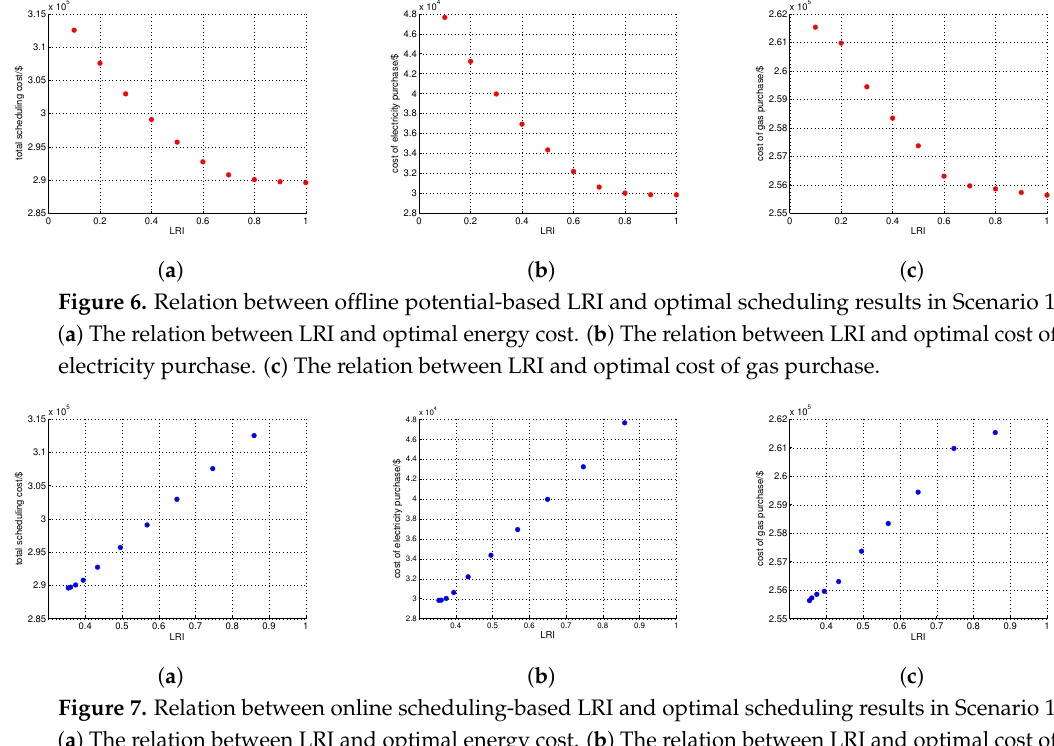
Figure 7. Relation between online scheduling-based LRI and optimal scheduling results in Scenario 1. ( a ) The relation between LRI and optimal energy cost. ( b ) The relation between LRI and optimal cost of electricity purchase. ( c ) The relation between LRI and optimal cost of gas